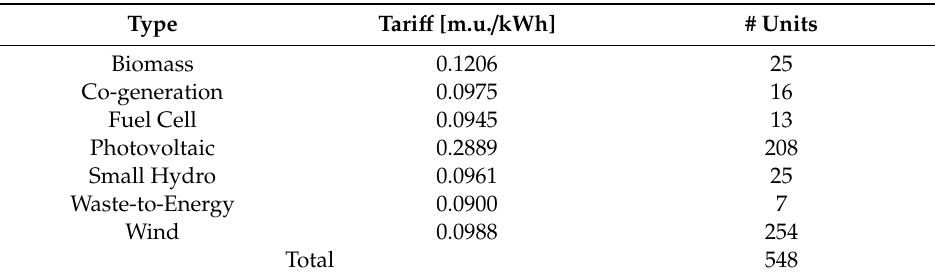
Table 1. Distributed generation units’